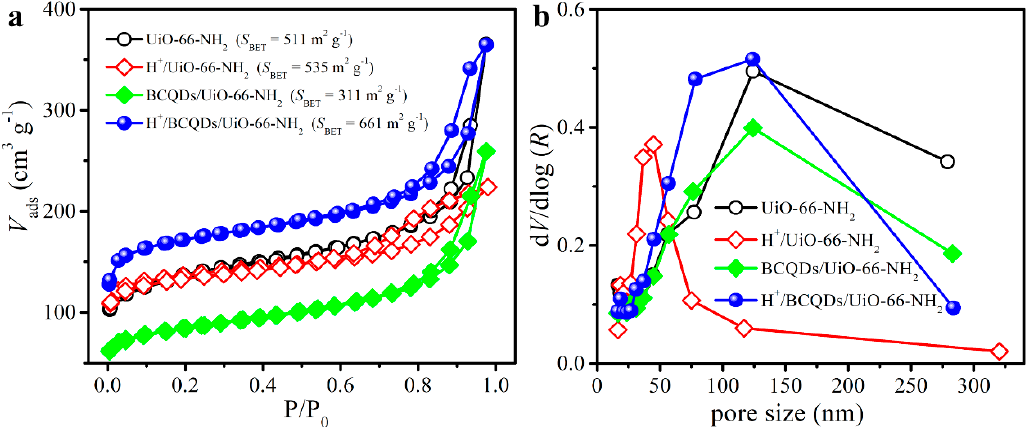
Figure 3. ( a ) Nitrogen sorption–desorption isotherms and ( b ) the corresponding pore size distribution curves of UiO-66-NH 2 , H + /UiO-66-NH 2 , BCQDs/UiO-66-NH 2 , and H + /BCQDs/UiO-66-NH 2 . The chemical structure of as-prepared catalysts of UiO-66-NH 2 , H + /UiO-66-NH 2 , BCQDs/UiO-66-NH 2 , and H + /BCQDs/UiO-66-NH 2 were further investigated by XPS. As